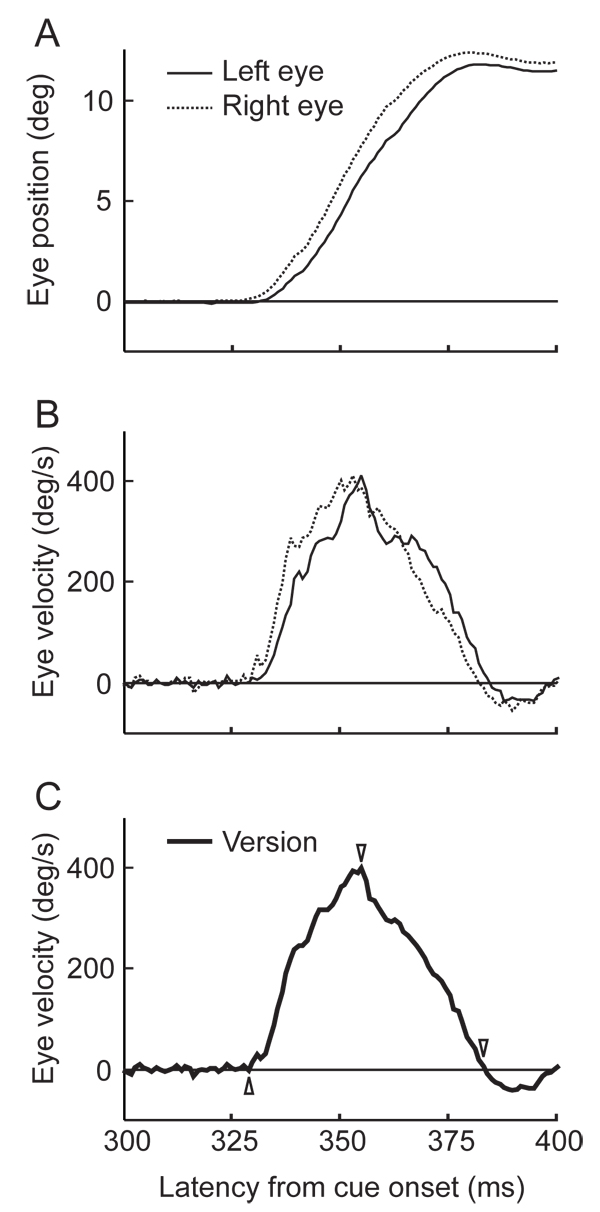
A, B. Example of different time courses in position and velocity between the left eye (solid lines) and the right eye (dotted lines), obtained from a single trial in which the saccadic target was on the right side. Positive deflections shown on the vertical axis of A, B and C denote rightward movements, and thus indicate the eye movement toward the target. C. Version velocity, i.e., the averaged velocity between the eyes. The saccade initiation, peak-velocity and end of the trial are indicated by arrowheads, based on the version velocity. Horizontal axis is taken from the onset of the arrowhead cue image (see Fig. 1).